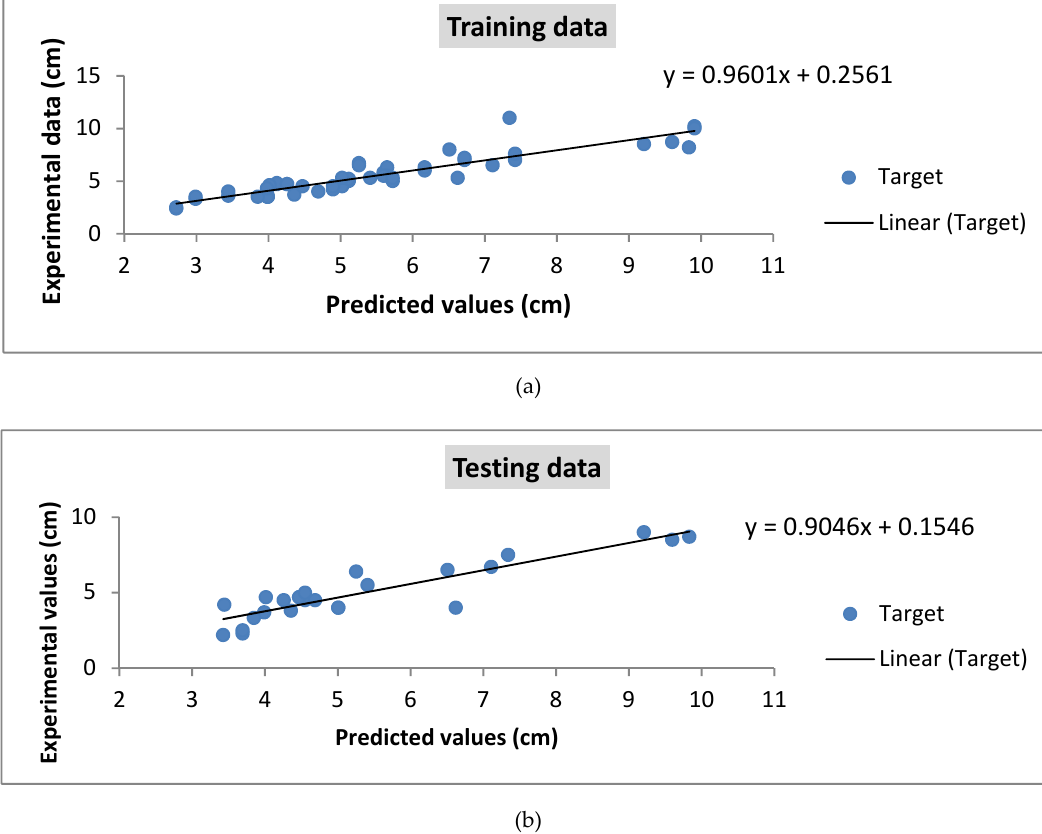
Table 10. The mathematical formulation of permeability of concrete samples containing nano-MgO proposed by the GEP